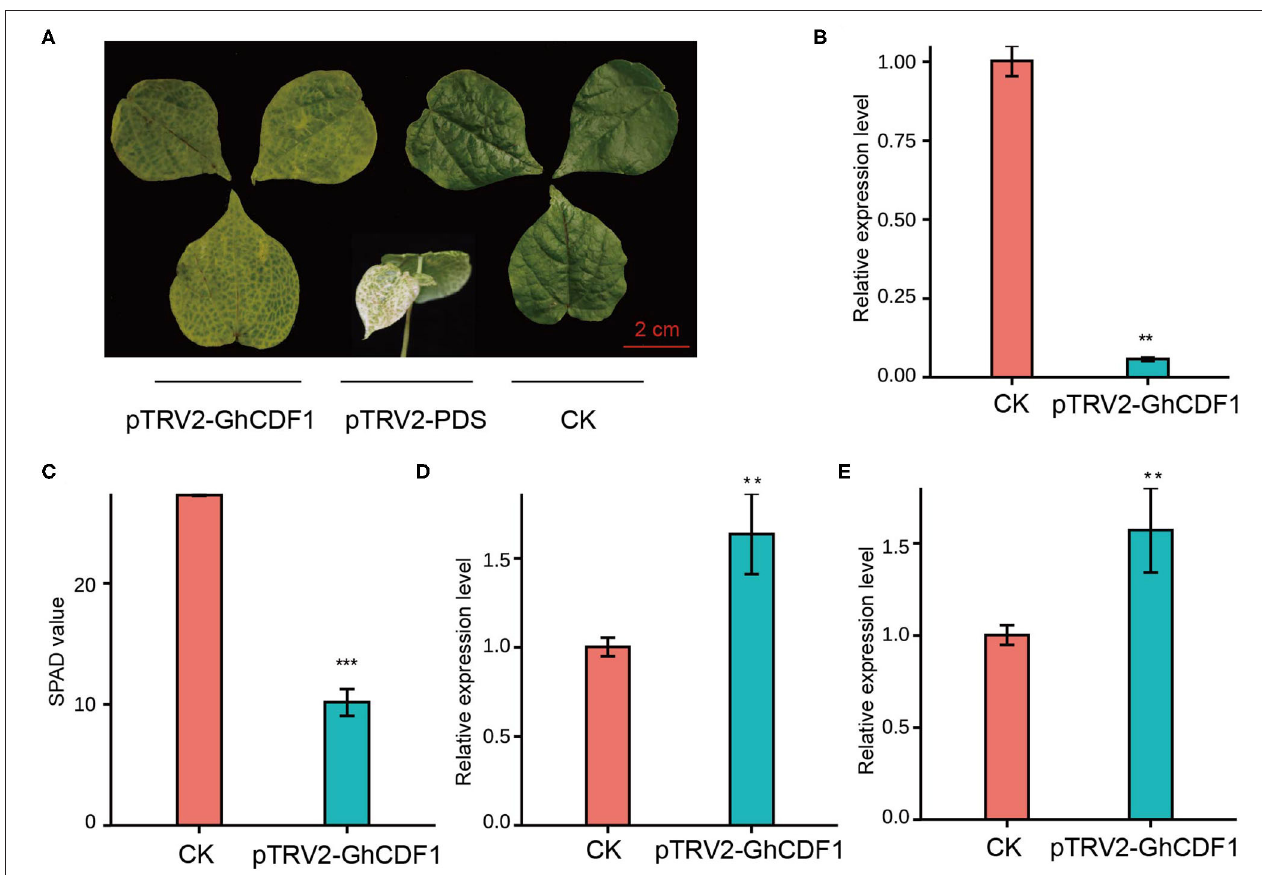
FIGURE 5 | Functional analysis of the candidate gene GhCDF1 (Ghir_D03G011060) using VIGS. (A) Plant phenotype of VIGS GhCDF1 in cultivar ’CRI50’. ’CRI50’ with pTRV2 was used as the control (CK). (B) Expression of GhCDF1 in VIGS plants. (C) SPAD values of the VIGS plants. (D) and (E) Expression of senescence-associated genes GhWRKY27 and GhWRKY42 . Asterisks indicate significance levels (*** P < 0.001, ** P < 0.01, and * P <